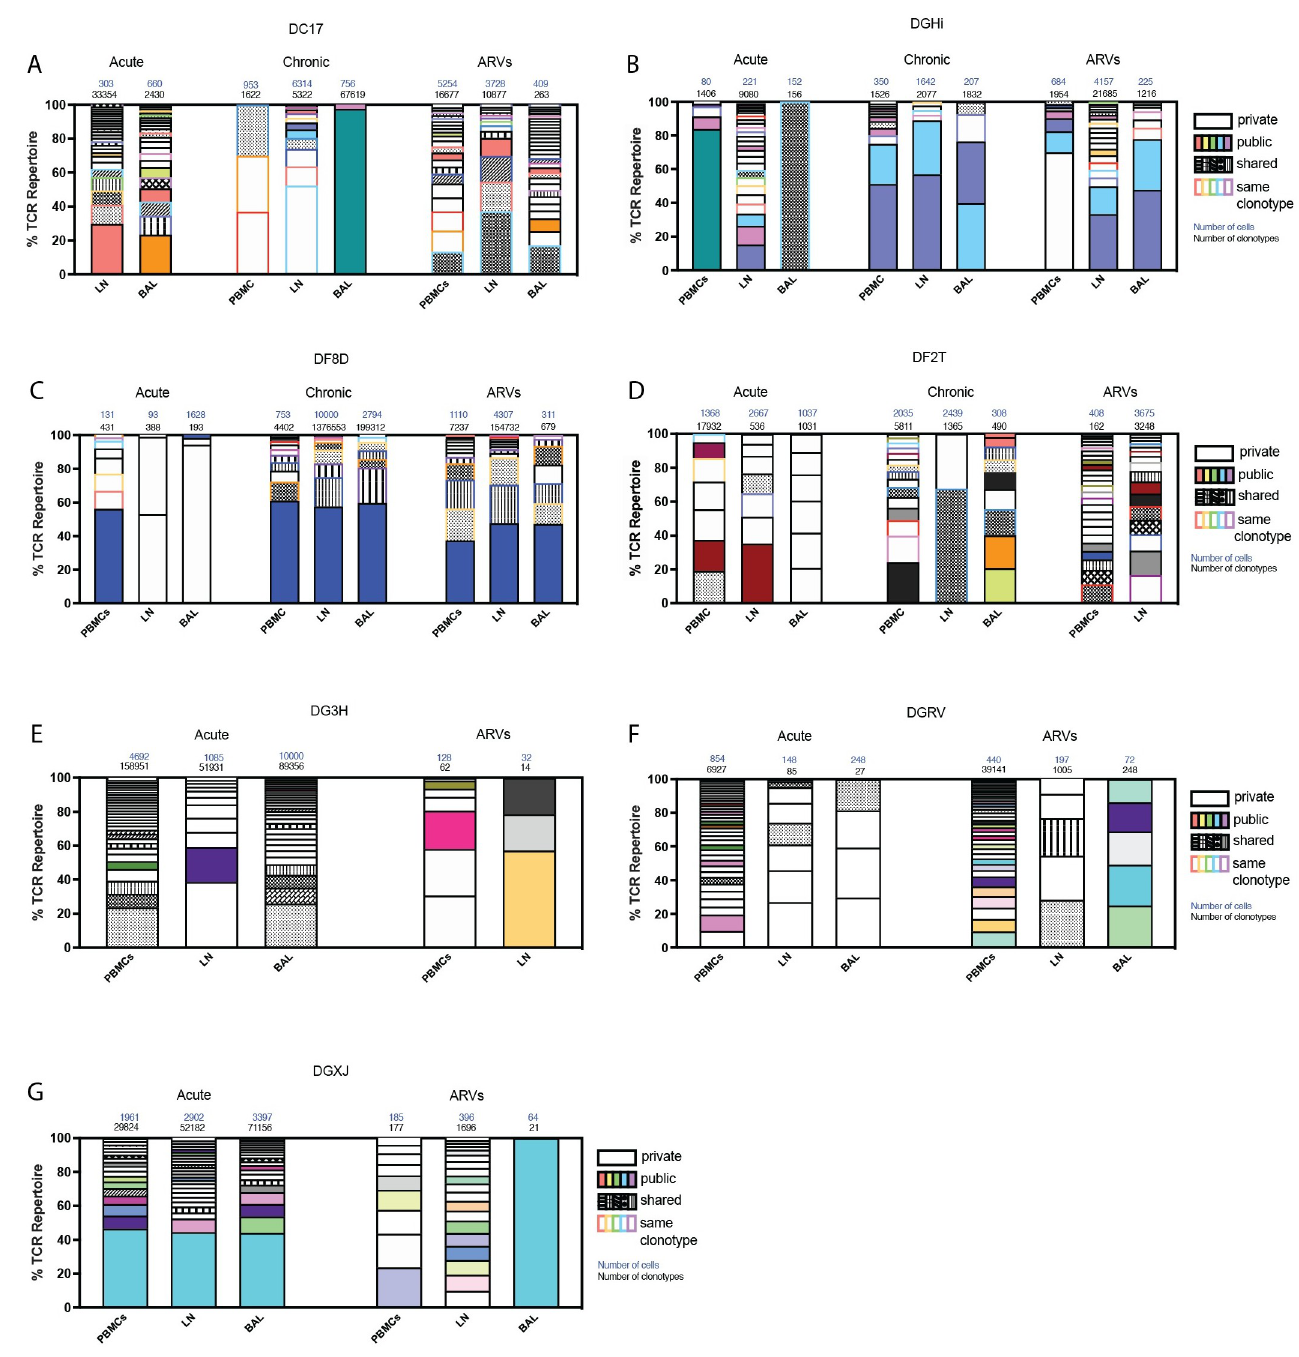
Fig 1. SIV-specific CD8 + T cell repertoire fluctuates throughout infection and during ARV treatment. PBMCs, LN biopsies and BAL were sampled from 7 different SIVmac239X or SIVmac239-infected rhesus macaques during acute infection, chronic infection and after 2–7 months of ARV treatment. (A-G). Clonotypes consisting of more than 1% of the TCR repertoire were represented as percentage of the TCR repertoire during acute and chronic infection and with ARV treatment. “Public” clonotypes are the same clonotype (same V and J segments and same CDR3 amino acid sequence) found in multiple animals in this study, and matching clonotypes previously identified in the VDJdb database. “Shared” clonotypes were those found only in one animal but observed in multiple tissues. “Private” clonotypes were identified in a single anatomical site in a single animal. n = 7 animals. Total cell and TCR sequences numbers are listed above each